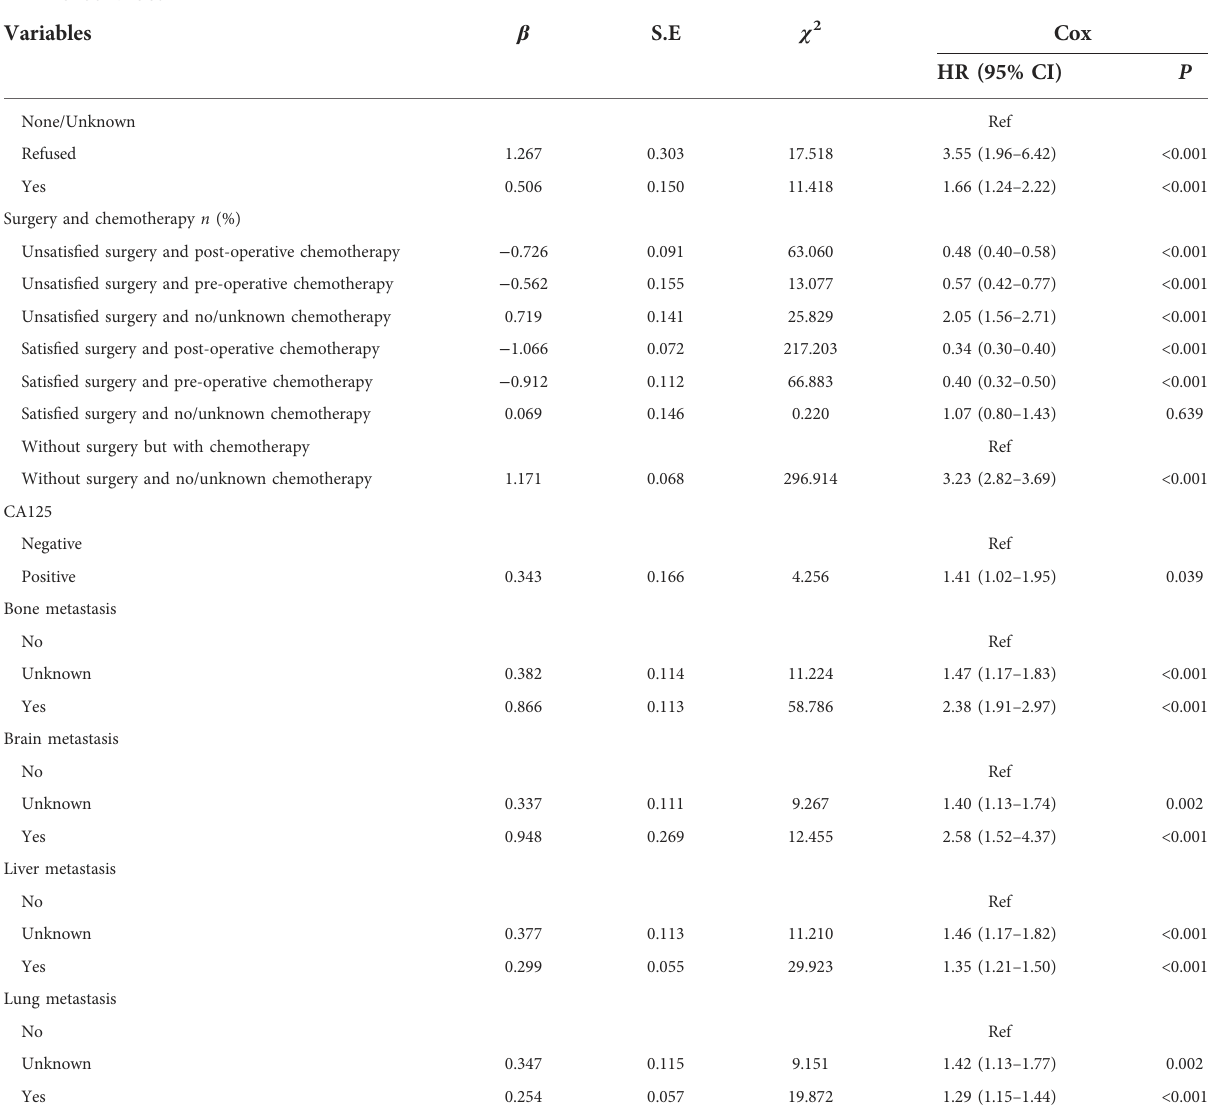
patients with positive CA125. Those with bone (HR = 1.56, 95%